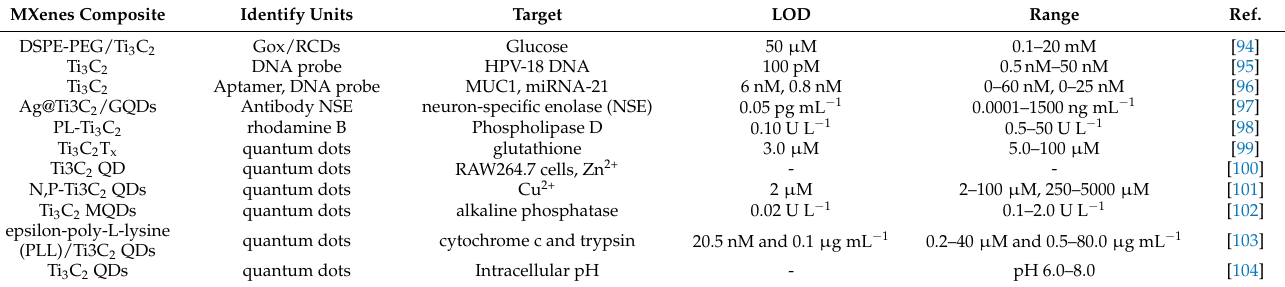
Table 4. MXene-based photoluminescence biosensors identify units, target, and analytical